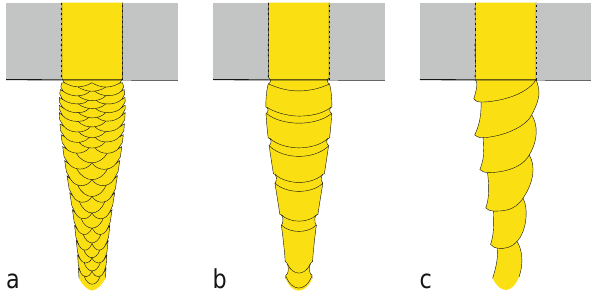
Figure 9. Illustration of the development of ( a ) sharkskin, ( b ) stick-slip (“bambooing”), and ( c ) gross